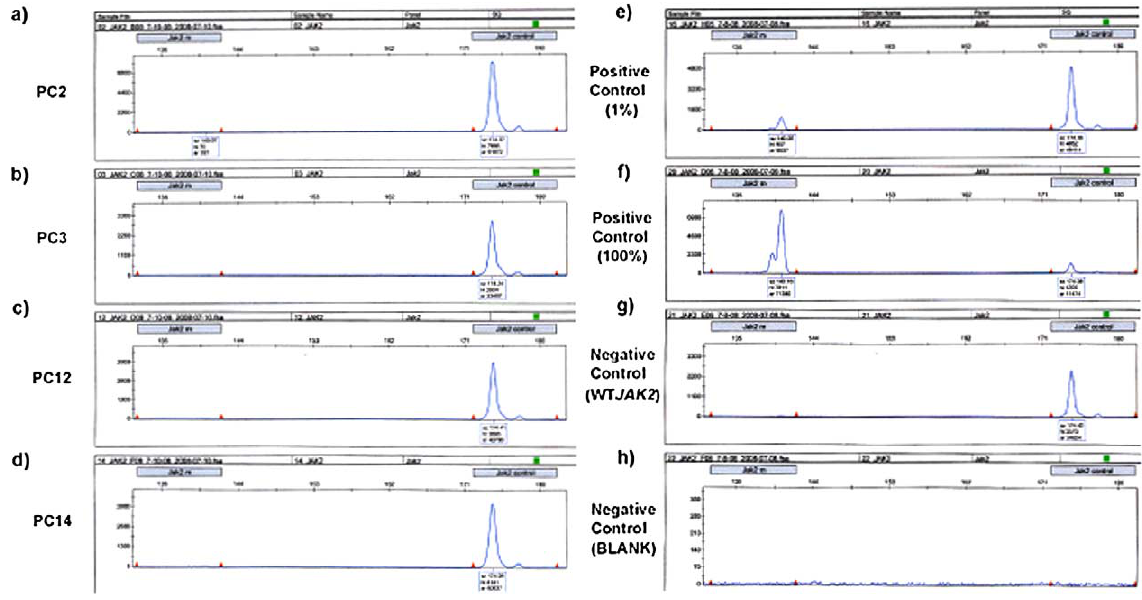
Fig. 1. Analysis of JAK2 V617F mutation using an amplification refractory mutation system (ARMS) assay in benign prostate hyperplasias, prostate intraepithelial neoplasias, primary prostate cancers of different histological grades and castration-resistant prostate cancers. Selected cases of prostate cancers (PC2, PC3, PC12 and PC14) are presented showing amplification of the 174 bp internal control peak only (a–d). The positive controls were the following: (1) Template containing 1% of DNA with the JAK2 V617F point mutation with 99% of DNA containing the wild type JAK2 sequence (1%) (e) and (2) 100% of DNA containing the point mutation (100%) (f). The positive controls show both of the peaks which represent the mutation at 140 bp and the 174 bp internal control peak. The results for 5%, 10% and 30% positive controls are not shown. DNA with the wild type (WT) JAK2 sequence showing the 174 bp internal control peak only was used as a negative control (g). An additional negative control which did not contain any template (BLANK) shows no amplification